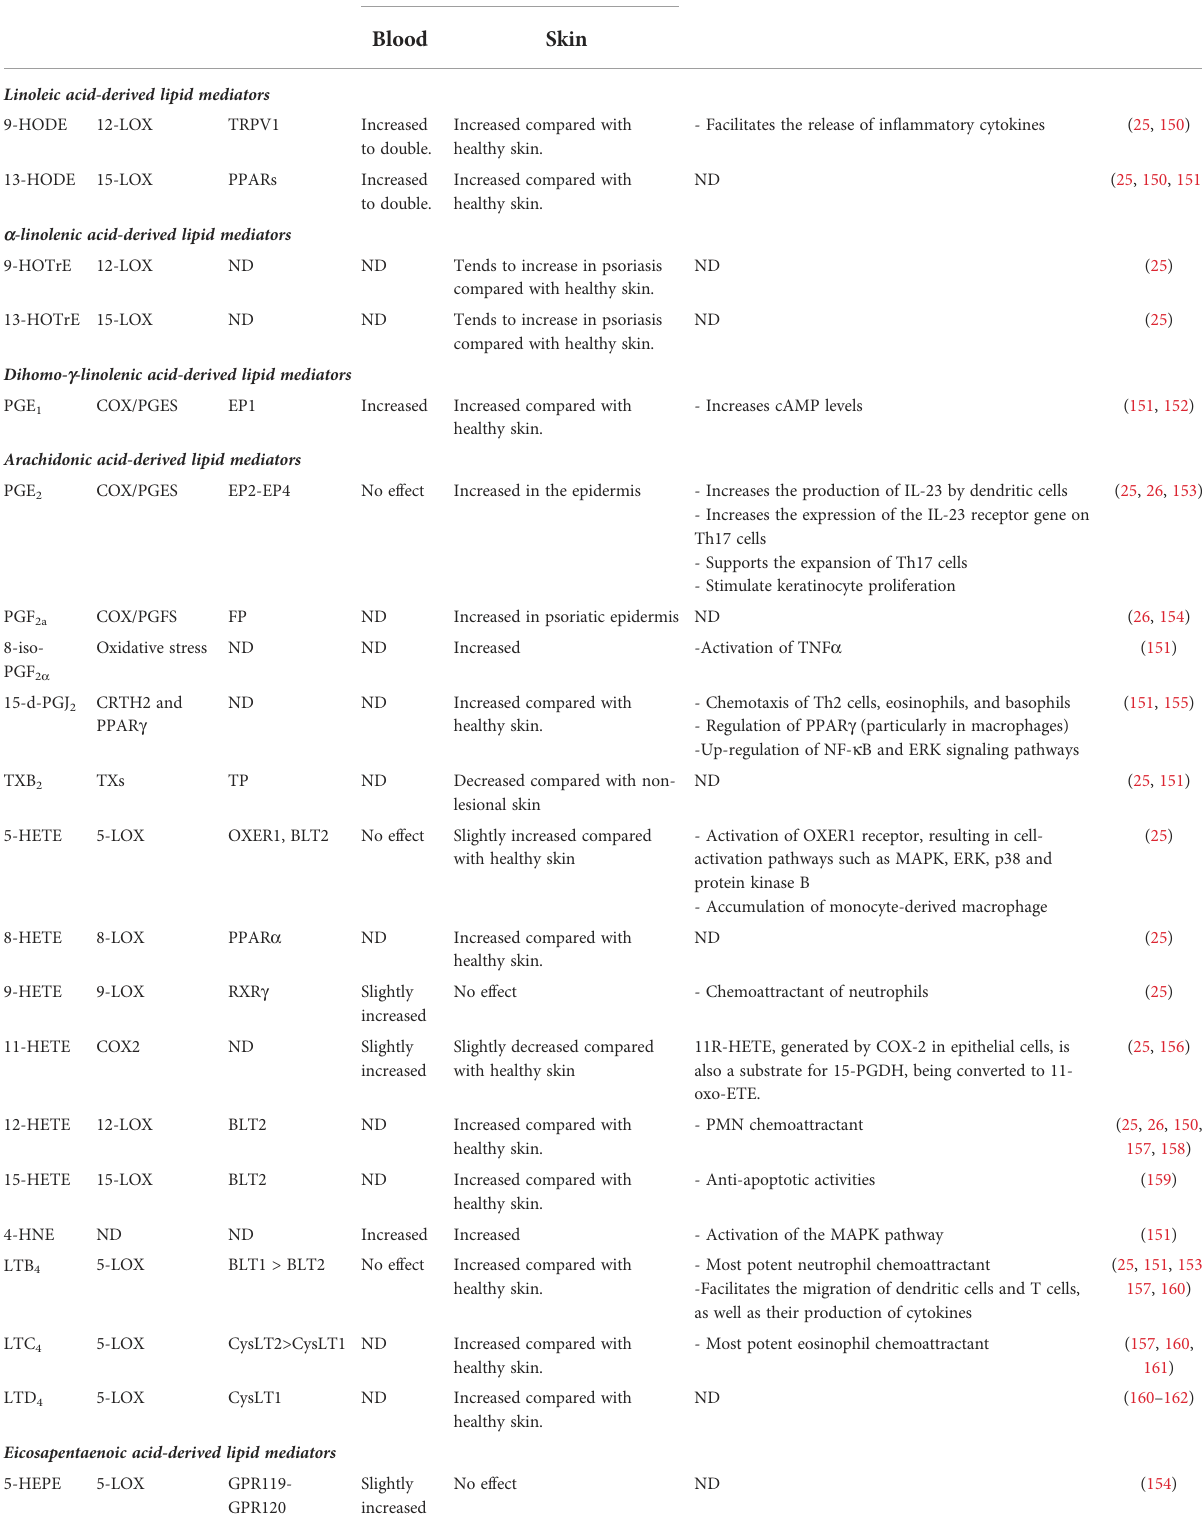
TABLE 1 Summary of lipid mediators involved in psoriasis. Markers